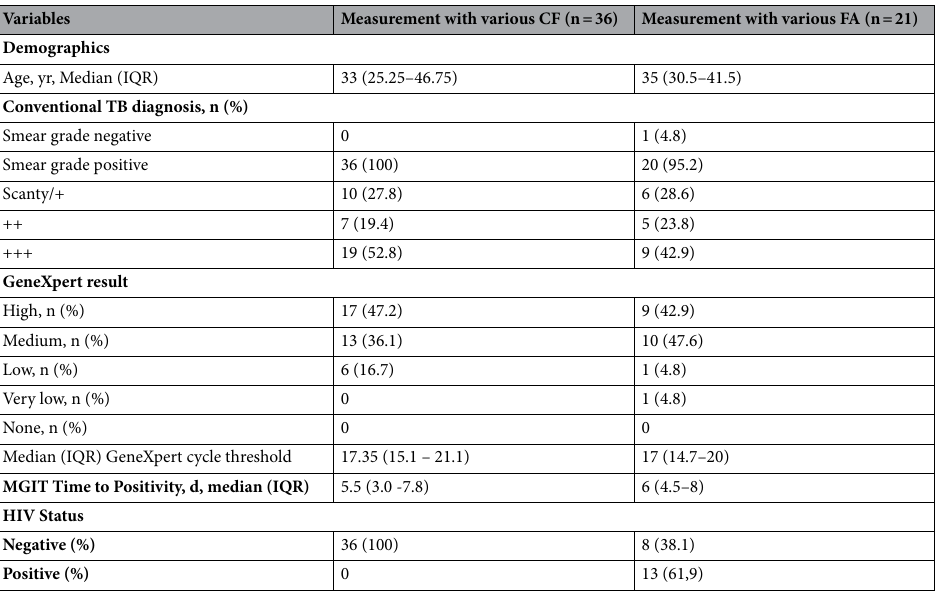
Table 1. Demographics and laboratory diagnostic data for participant specimens tested with various CFs and FAs. yr years, d days, IQR interquartile range, MGIT mycobacterial growth indicator